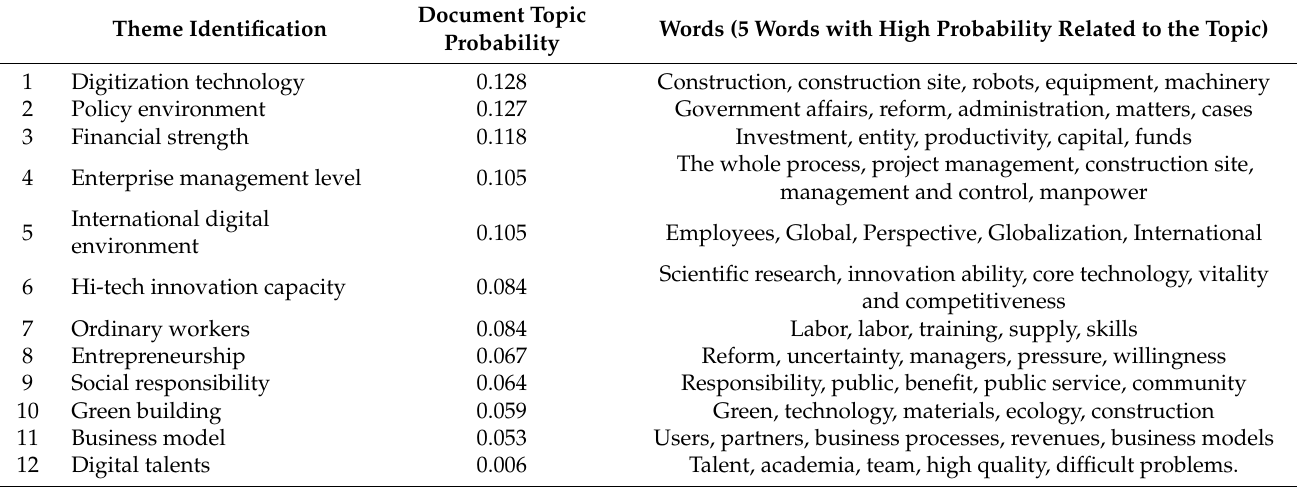
Figure 4. The visualization of Pyldavis theme-key influencing factors for the digital construction industry. Table 2. The theme-term distribution of key influencing factors for digital transformation of the construction industry.